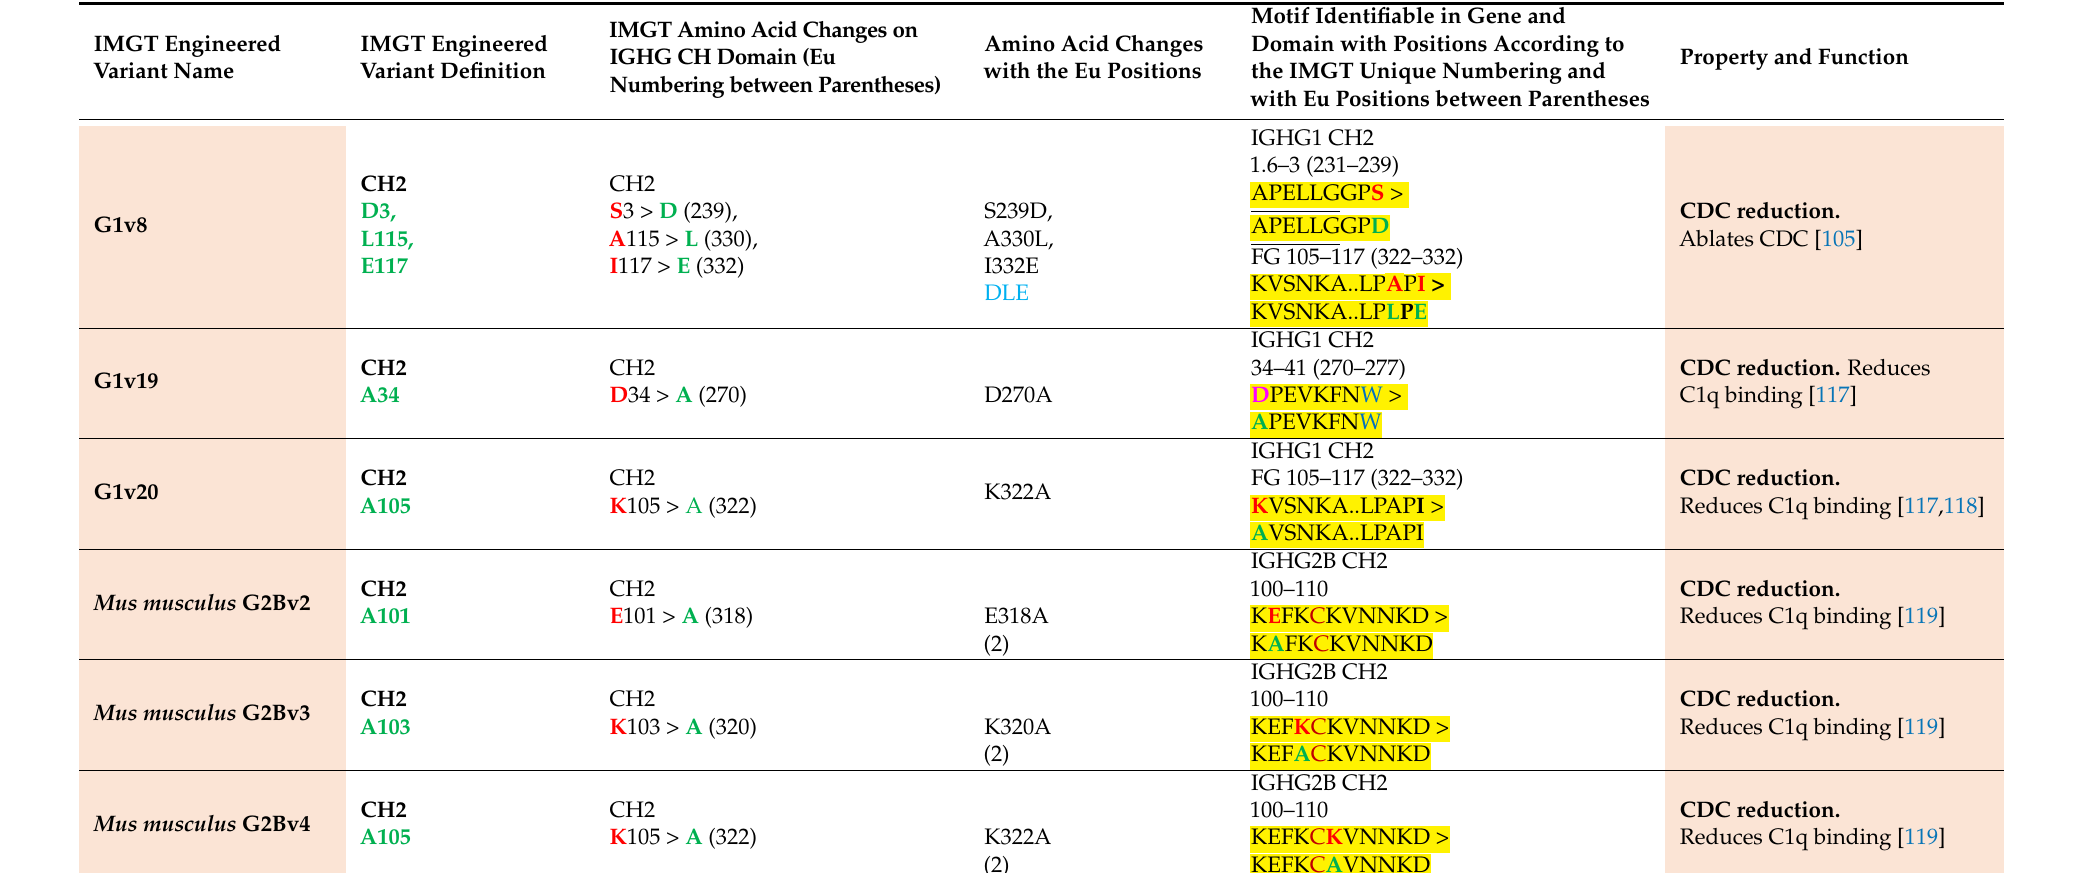
Table 9. IMGT nomenclature, Eu positions and IMGT motif of engineered Fc variants involved in complement-dependent cytotoxicity (CDC) reduction (Effector